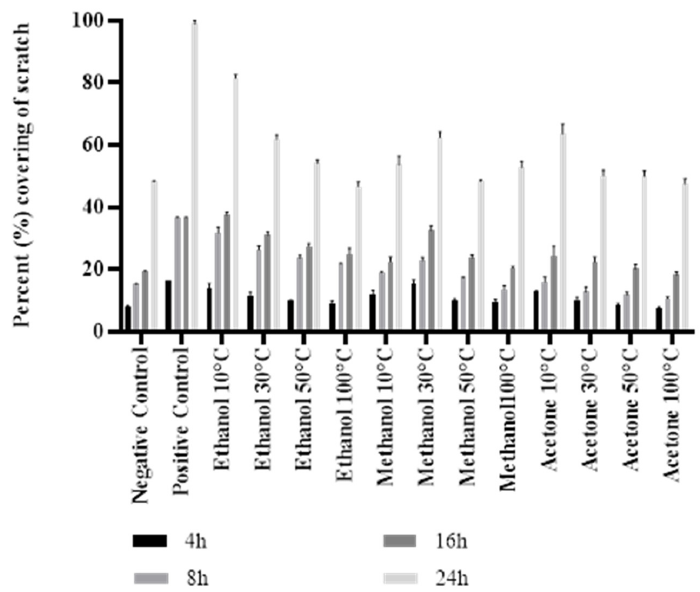
Figure 7. Cell proliferation activity of M. oleifera extracts on RPE cells. Twelve different M. oleifera extracts were prepared by drying the leaves at variable temperatures and extracting them in three different solvents at 0.1 mg/mL. Evaluations were conducted after different intervals, i.e., 4, 8, 16, and 24 h of incubation. The negative and positive controls were PBS and PDGF, respectively. Bars represent the mean ± standard deviation.